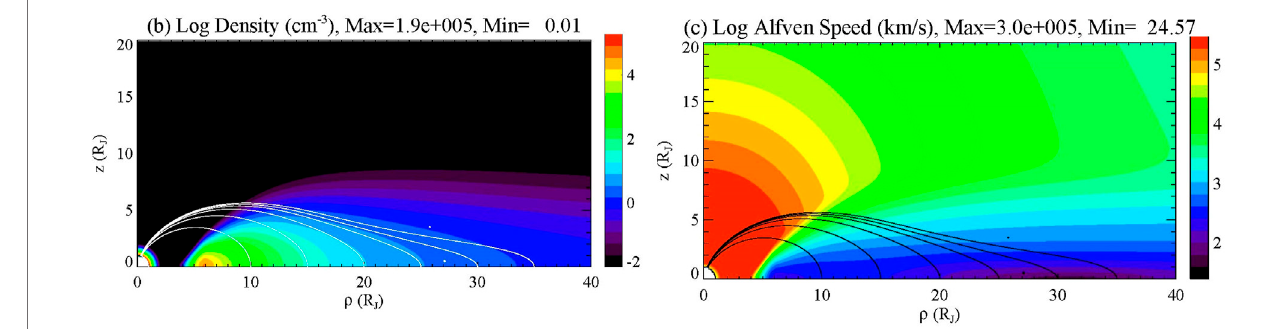
FIGURE 2 | A meridional cut of the density (left) and Alfvén speed (right) for a model of Jupiter ’ s magnetosphere (adapted from Lysak and Song (2020), updated with the Connerney et al. (2020) magnetic fi eld model) with ρ being the cylindrical distance from Jupiter ’ s magnetic axis and z is the distance above the equatorial plane. Representative model fi eld lines are indicated by the white lines in the left fi gure and black lines in the